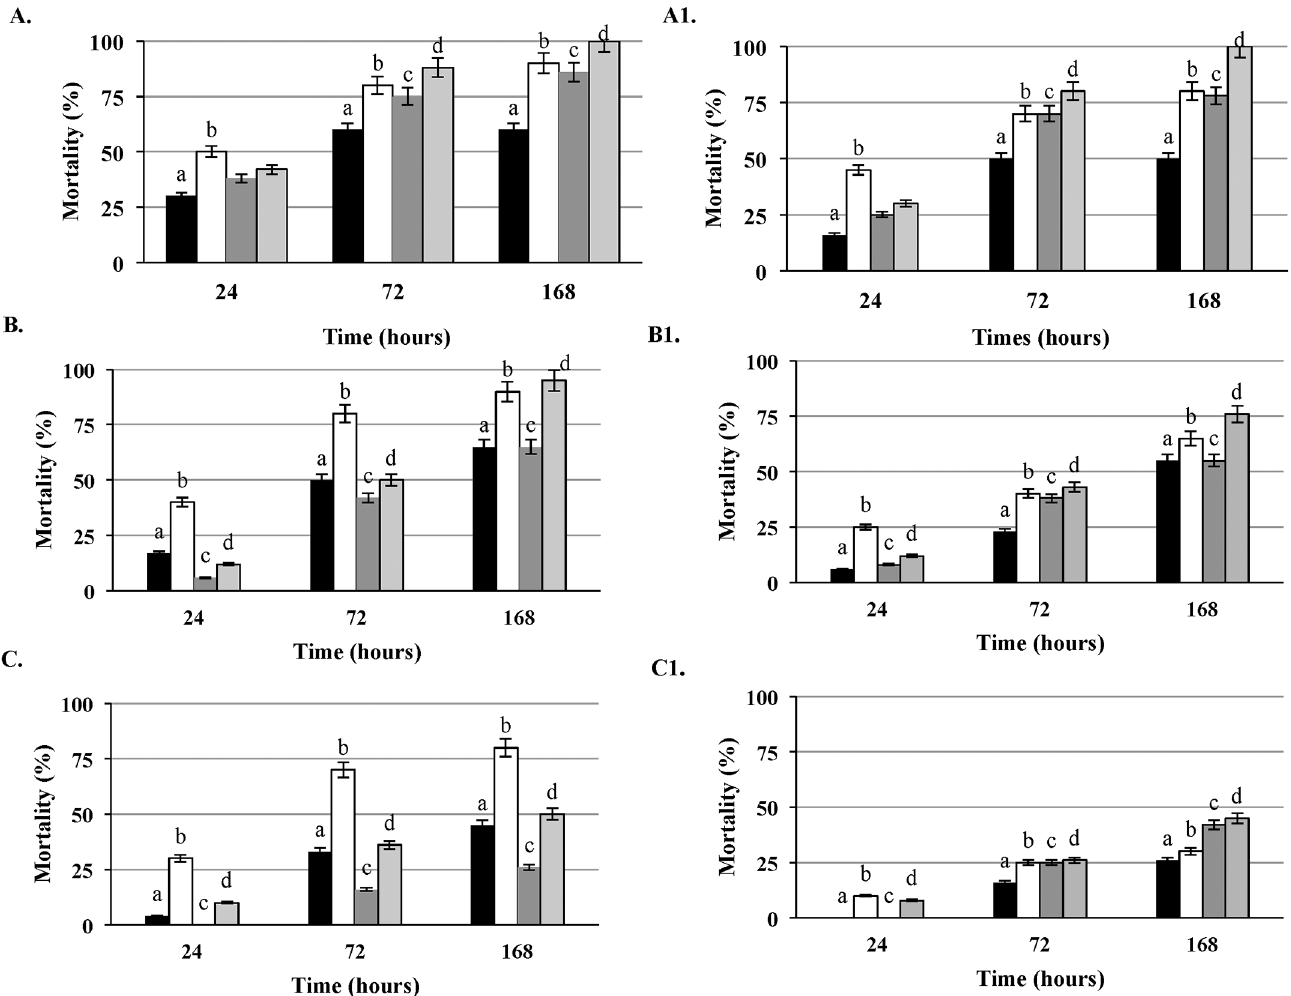
Fig 6. Comparison of the virulence potential of clinical and food isolates of L . monocytogenes strains related to listeriosis outbreakswith invasive and non-invasive (gastroenteritis) symptoms. Paralleltesting of the clinicalisolatesof the same serotyperelatedto non-invasive (LS405– designatedwith blacksquare and LS403-designated with dark gray square)and invasive(LS740-designatedwith white square and LS414-designated with light gray square)outbreaks at the inoculumconcentrations of 10 6 CFU/larva(6A), 10 5 CFU/larva(6B) and 10 4 CFU/larva(6C); Pairedfood isolates relatedto non-invasive (LS404- designated with black squareand LS402-designated with dark gray square)and invasive (LS670- designated with white square and LS413-designated with light gray square)outbreakshave also beencomparedat the inoculumconcentrations of 10 6 CFU/larva (6A1), 10 5 CFU/larva (6B1)and 10 4 CFU/larva(6C1); a < b (P < 0.05), c < d (P < 0.05).